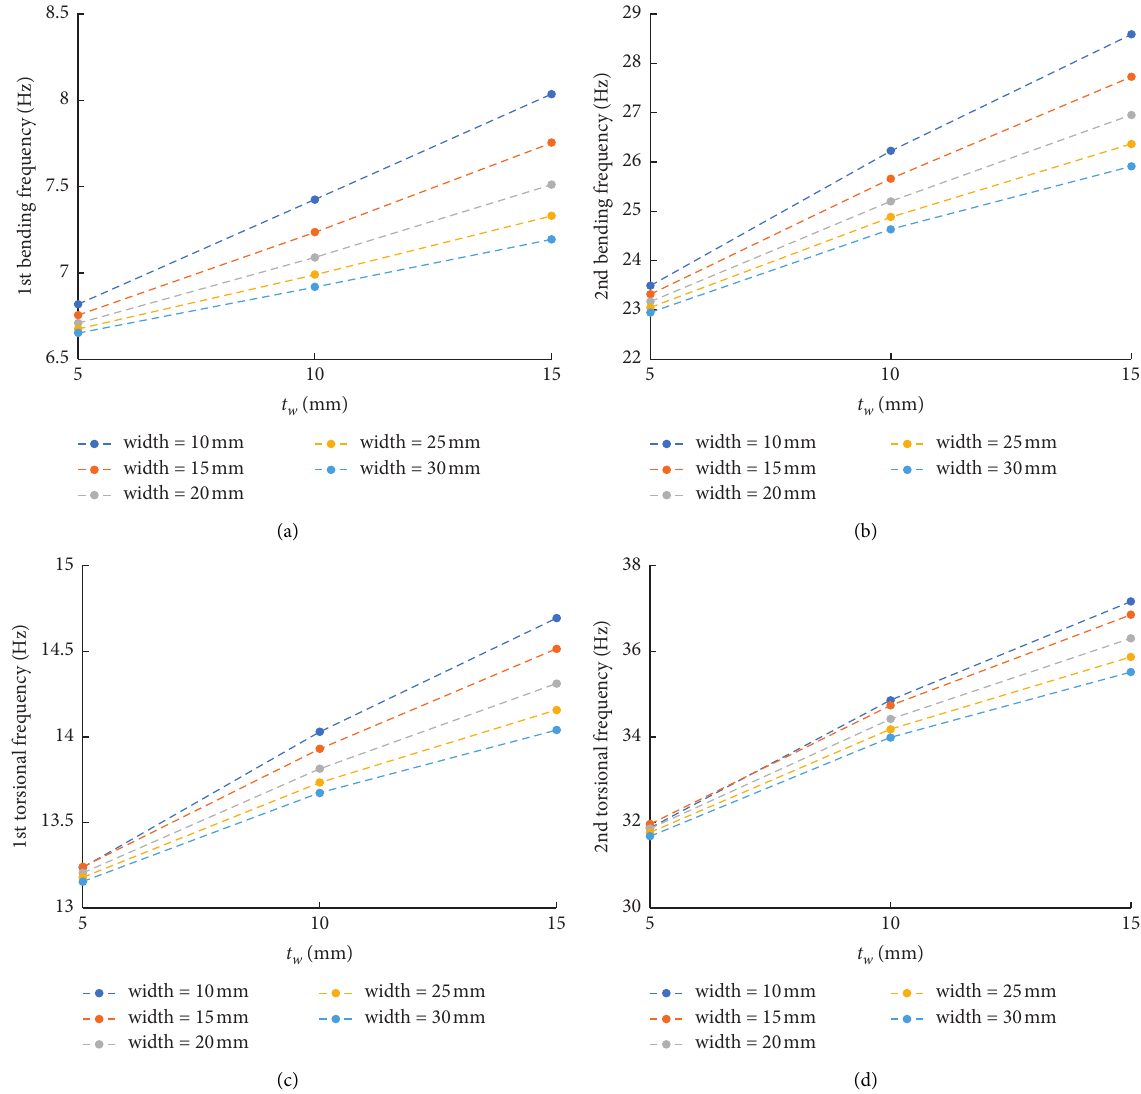
Figure 13: Natural vibration frequencies with t